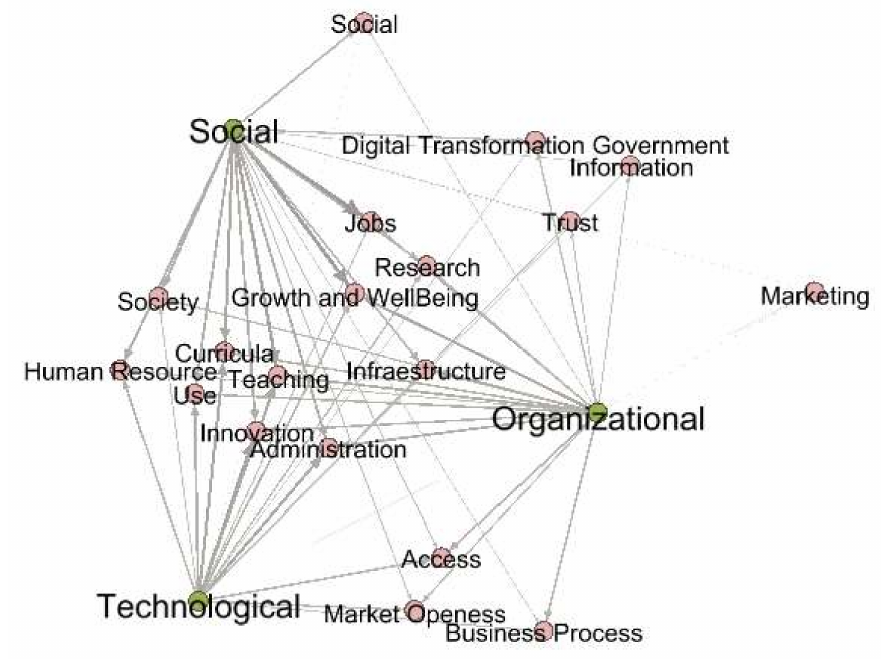
Figure 7. Goals of DT in HEIs.